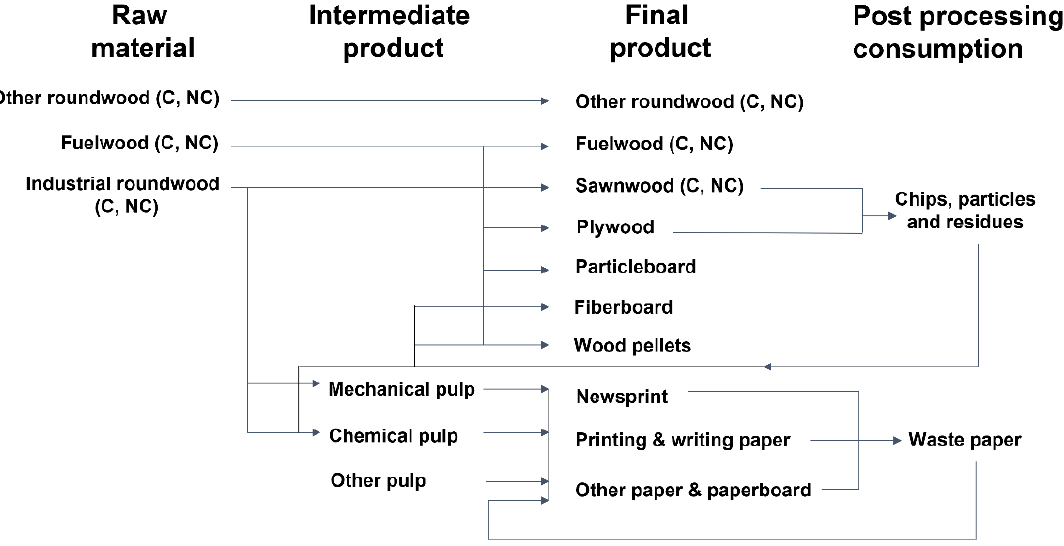
Figure 1. Forest product flow chart in FOROM.